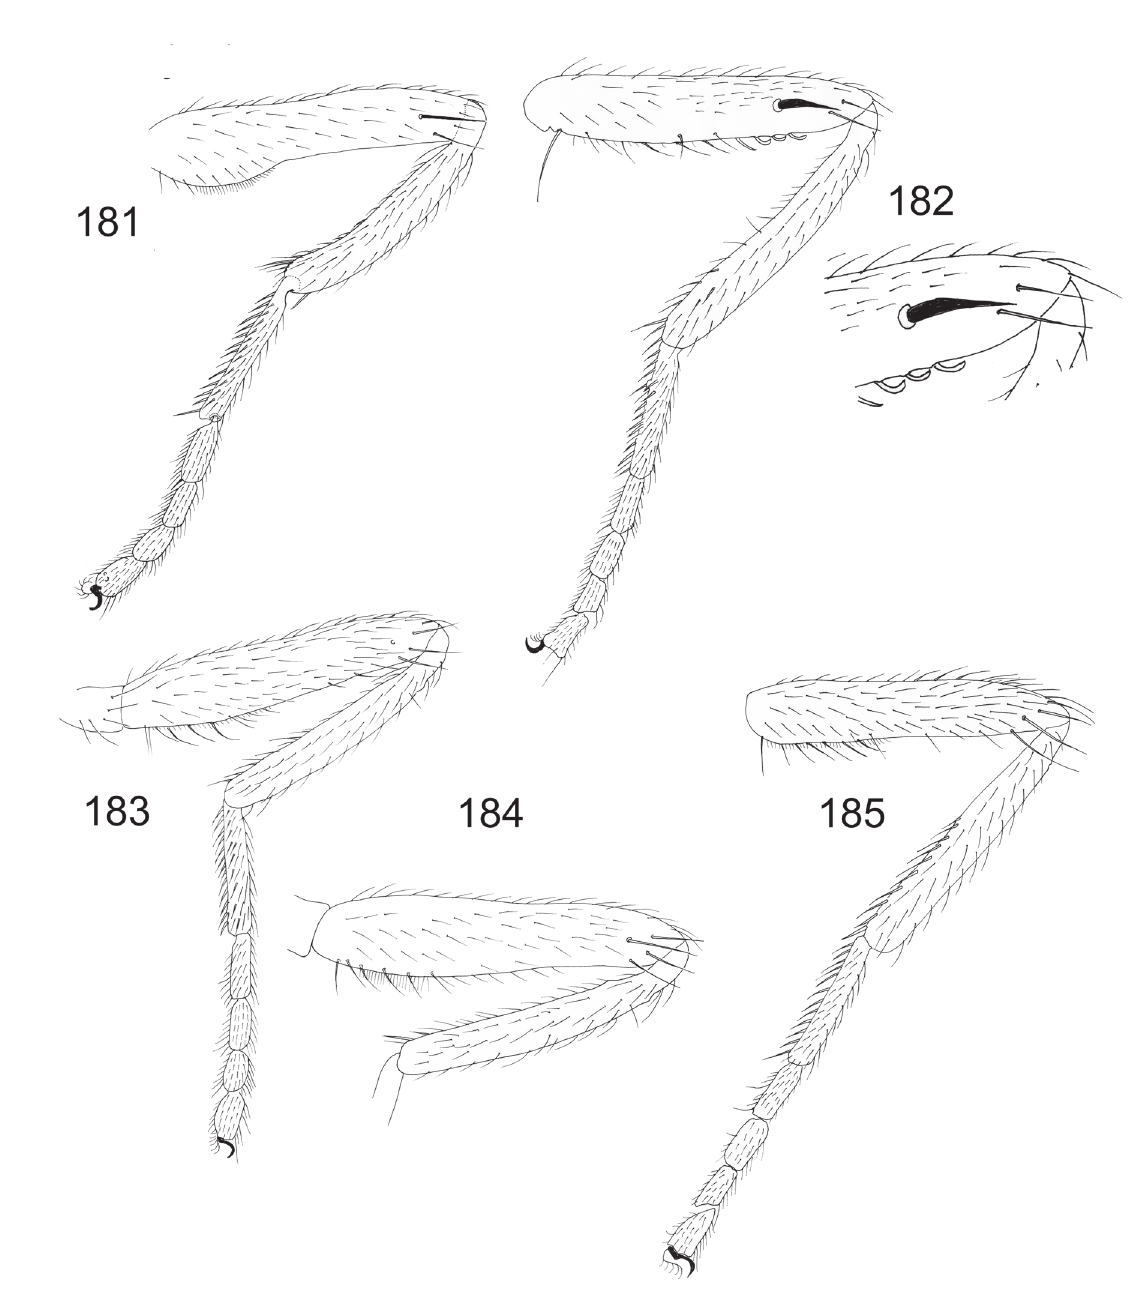
Figs 181-185. Nanodromia , ♂, mid leg, anterior view. 181 . N. narmjeud Grootaert & Shamshev, 2003. 182 . N. phukhao Grootaert & Shamshev, 2003. 183 . N. taksin Grootaert & Shamshev, 2003. 184 . N. spinulosa sp. nov. 185 . N. narmkroi Grootaert & Shamshev, 2003. (Figs 181-183, 185 from Grootaert & Shamshev